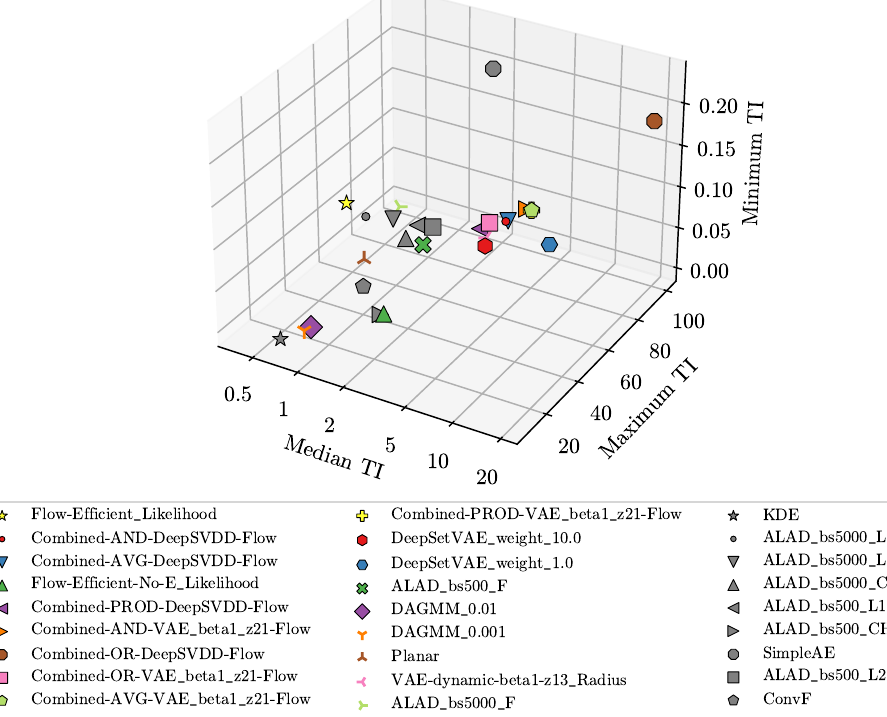
Figure 22: The minimum, median, and maximum best total improvements for each technique applied on each of the signals in the secret